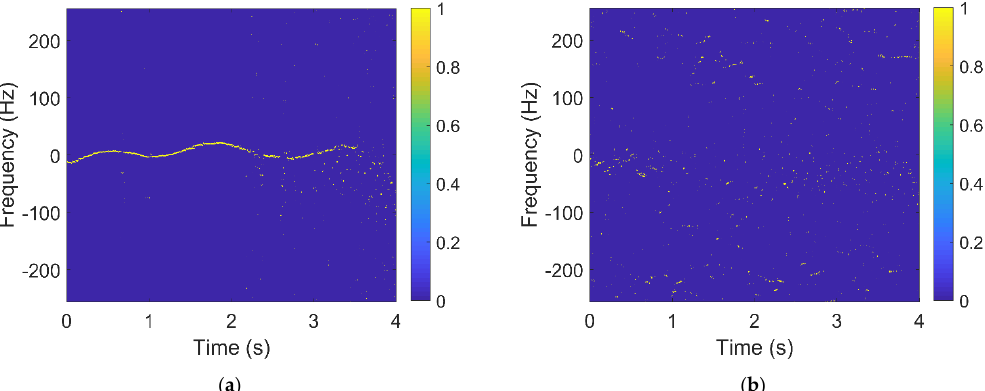
Figure 9. Important time–frequency points (ITFP) figures of target echo and sea clutter. ( a ) ITFP of target echo; ( b ) ITFP of sea clutter.